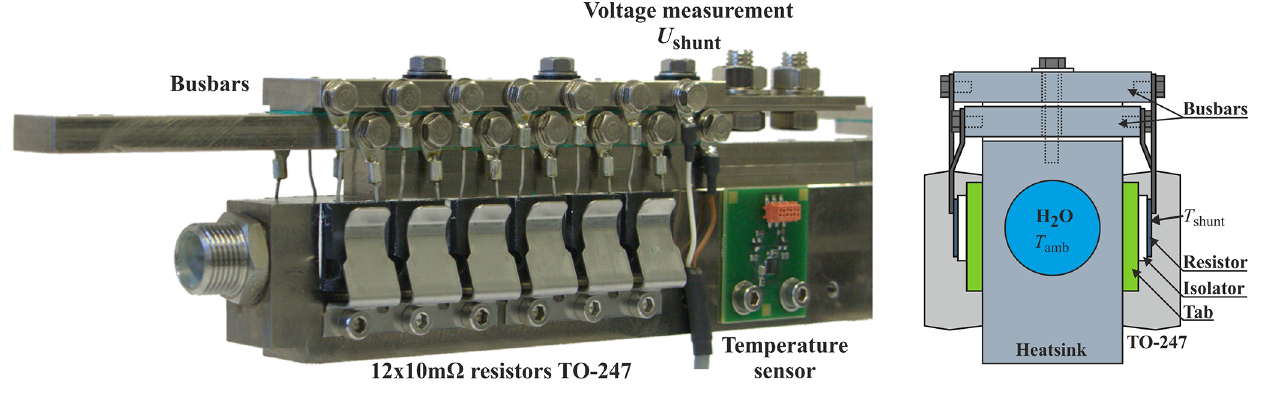
Figure 1. The 1m (cid:127) shunt resistor for lithium-ion cell test equipment, consisting of 12 10m (cid:127) shunt resistances in a TO-247 package mounted on a heat sink with water cooling. Left: photograph with annotations. Right: cross section.